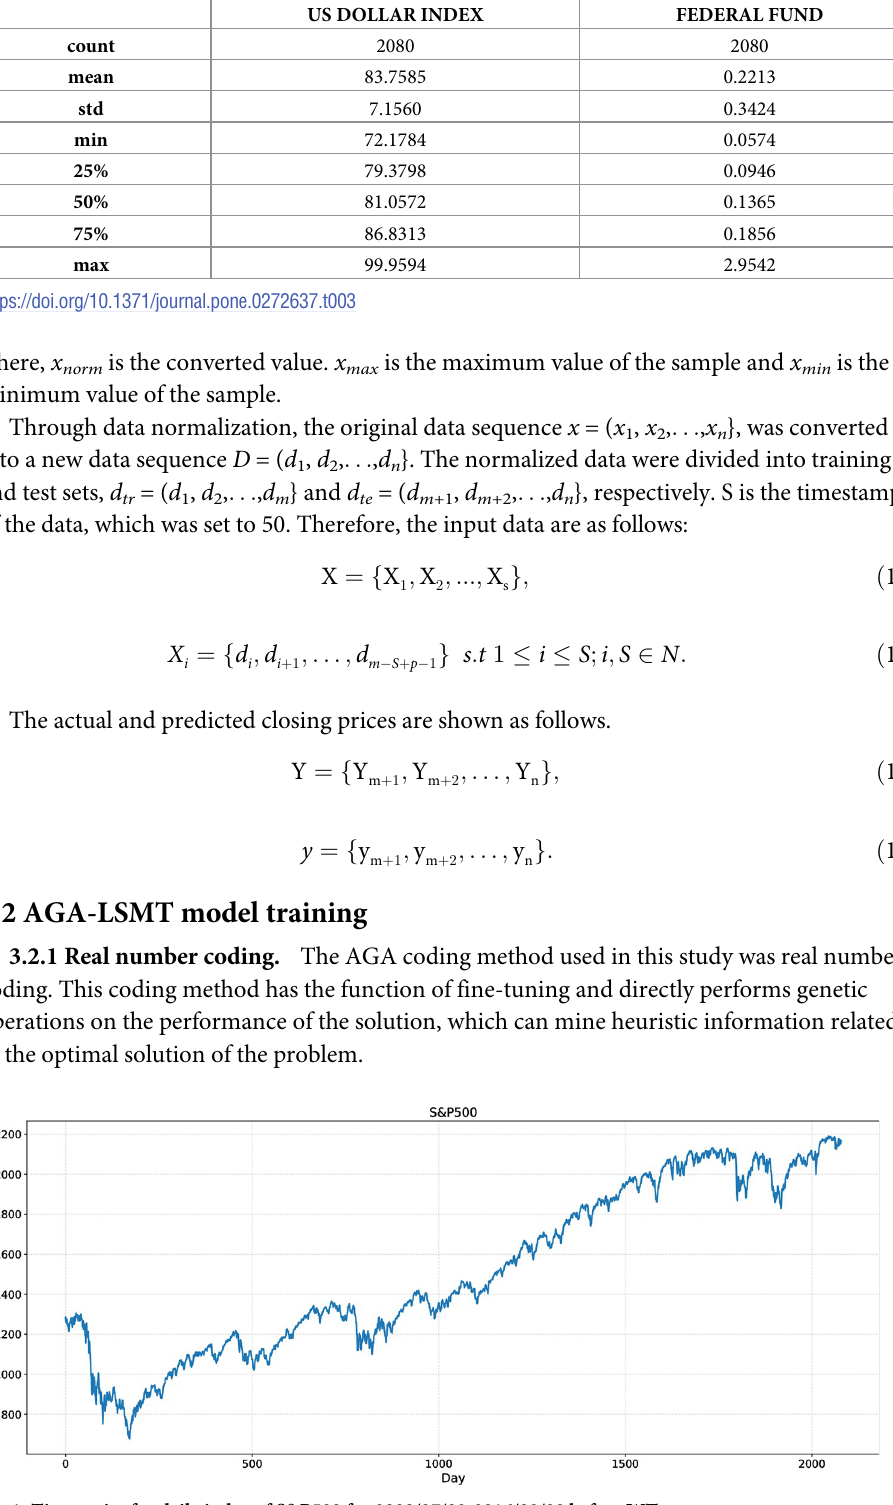
Fig 4. Time series for daily index of S&P500 for 2008/07/02-2016/09/30 before WT.